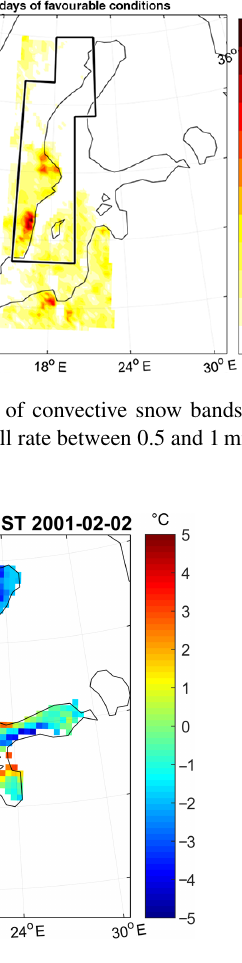
Figure 7. Difference map of the SST by ERA-40 and NEMO for 1 day of case